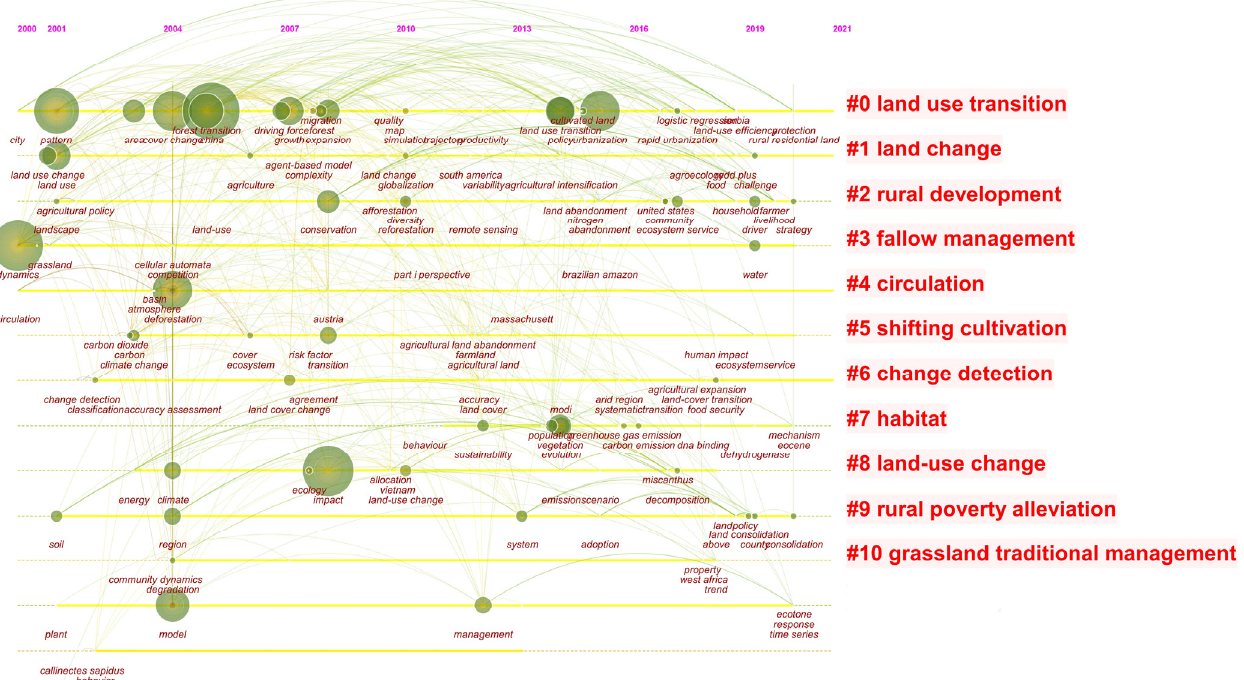
Figure 3. Timeline map of LUT research.